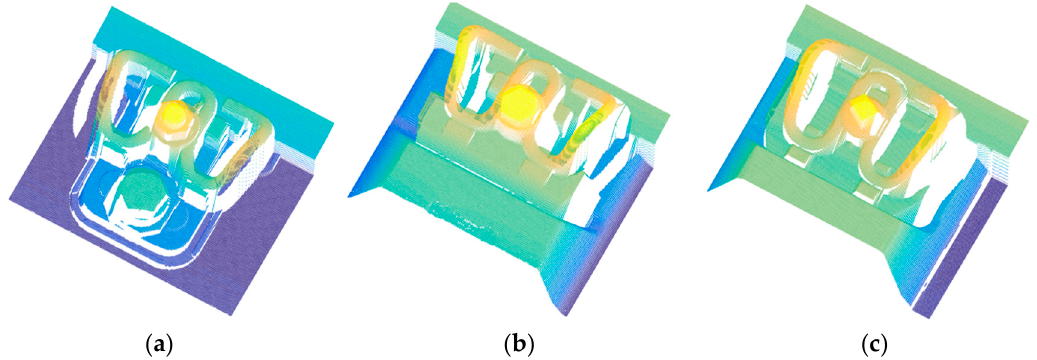
Figure 10. Extracted point cloud of the most commonly used fasteners in high-speed railways in China: ( a ) WJ-7; ( b ) WJ-8; and ( c ) Vossloh-300.